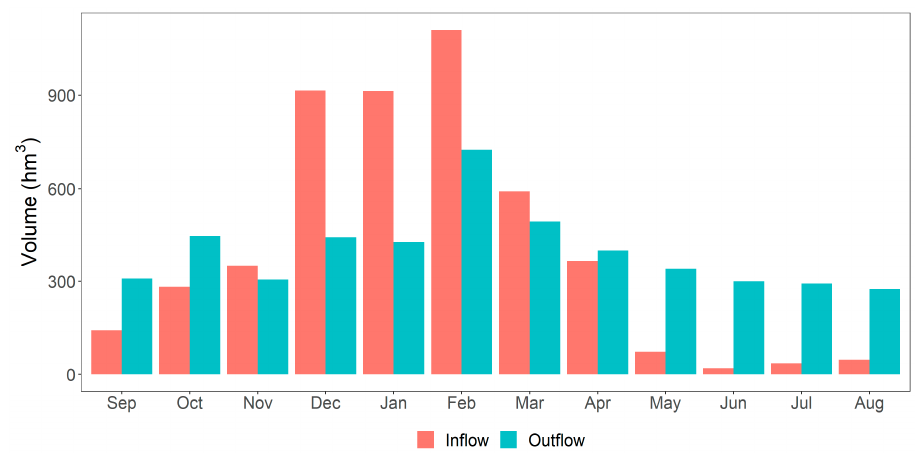
Figure 7. Monthly average of water inflows and outflows to the study area (2010–2018).